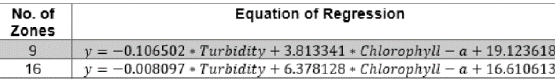
Table 8: Equations of Regression of the Two Zonations